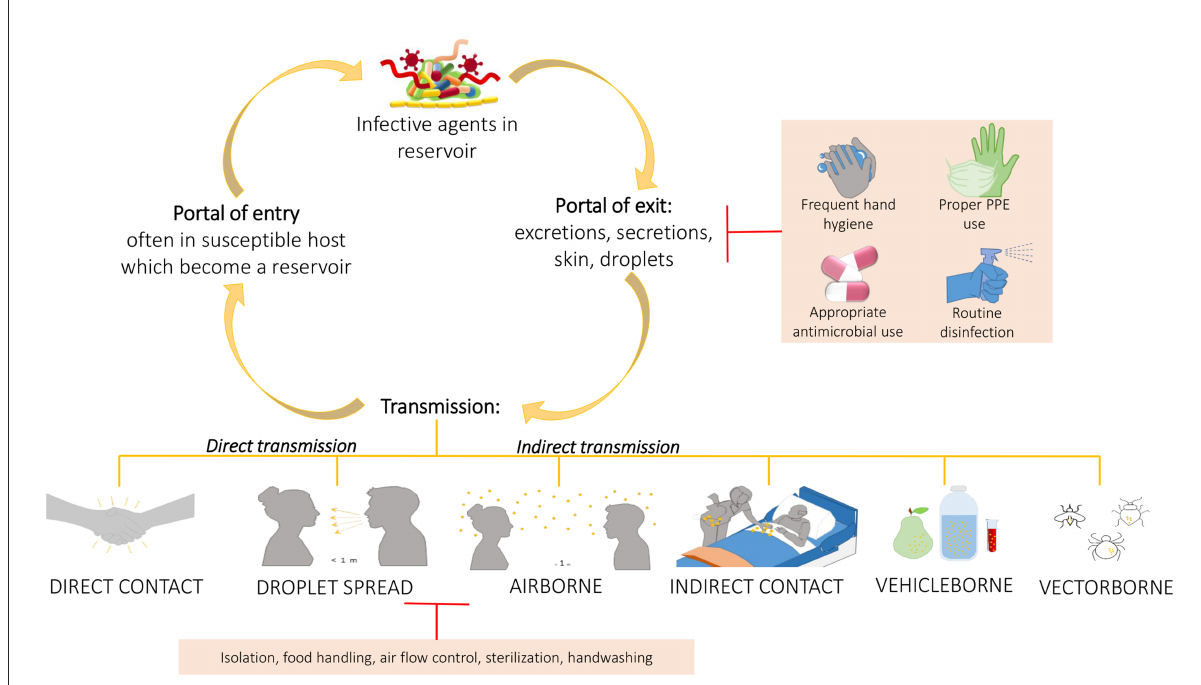
FIGURE4 Chain of infection and some preventing strategies. A pathogen may be transmitted from a reservoir to susceptible individual through different ways. Understand the chain of infection is fundamental to HAIs prevention and control. In direct transmission, the pathogens is transferred from a reservoir to an host by direct contact such as skin-to-skin contact, or droplet spread where aerosols produced by coughing, sneezing, or even talking lead to pathogens spreading. Conversely, indirect transmission is associated to an intermediary which may be both animate (vectors) or inanimate (vehicles). Belong to this class the airborne transmission where the pathogens are included into the droplet nuclei suspended in air, this is similar to the previous but the spreading may occurs also some distance away from the source resident due to conditioner systems or air currents. In the transmission through indirect contact, different objects, such as medical devices, contaminated gloves, object in the patients’ room or environment and/or medical equipment, may represent the source of contamination as well as inanimate vehicles such as food, water or other biological samples. Sometimes the vehicles are passively, other times they may aid the pathogens providing environment for growth. Similarly occurs for vectors which in general are animals such as mosquitoes, fleas, and ticks. The chain of infection may be interrupted at the “portal of exit” applying hygienic procedure such as the frequent hand hygiene, using proper personal protective equipment, performing proper routine disinfection, or using appropriately the antimicrobial to avoid strengthen antimicrobial resistance of pathogens. Sometime it is possible, instead, to break the transmission limiting the transmission itself through isolation of the infected individual, through a correct food handling, or through the application of sterilization and hygienic